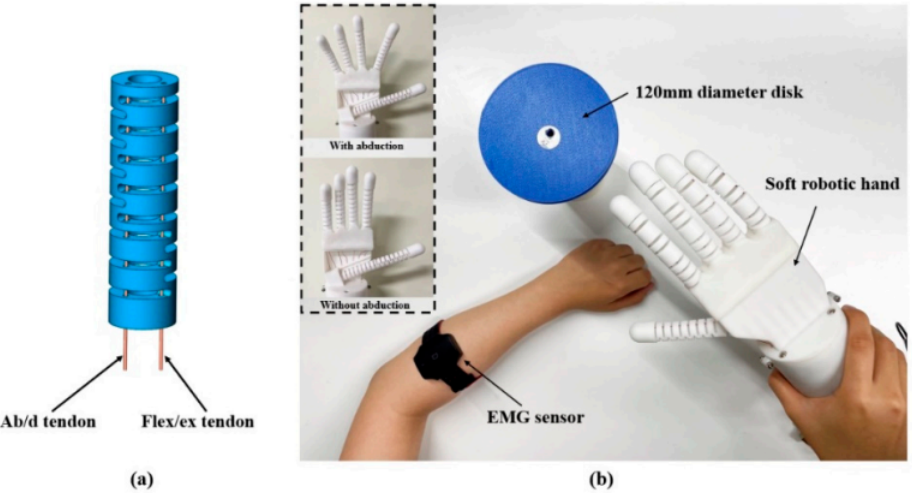
Figure 5. The soft robotic hand used to evaluate the grasp success rate. ( a ) The two-DOF MCP joint; ( b ) grasping a 120 mm diameter disk with a soft robotic hand. Left: two pregrasp